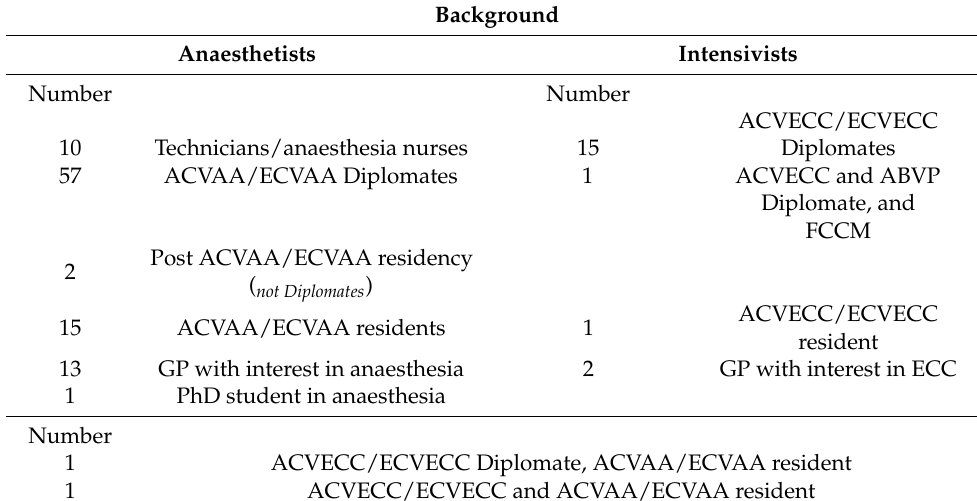
Table 1. Demographics of the 128 respondents to a survey on the use of spirometry in small animal anaesthesia and critical